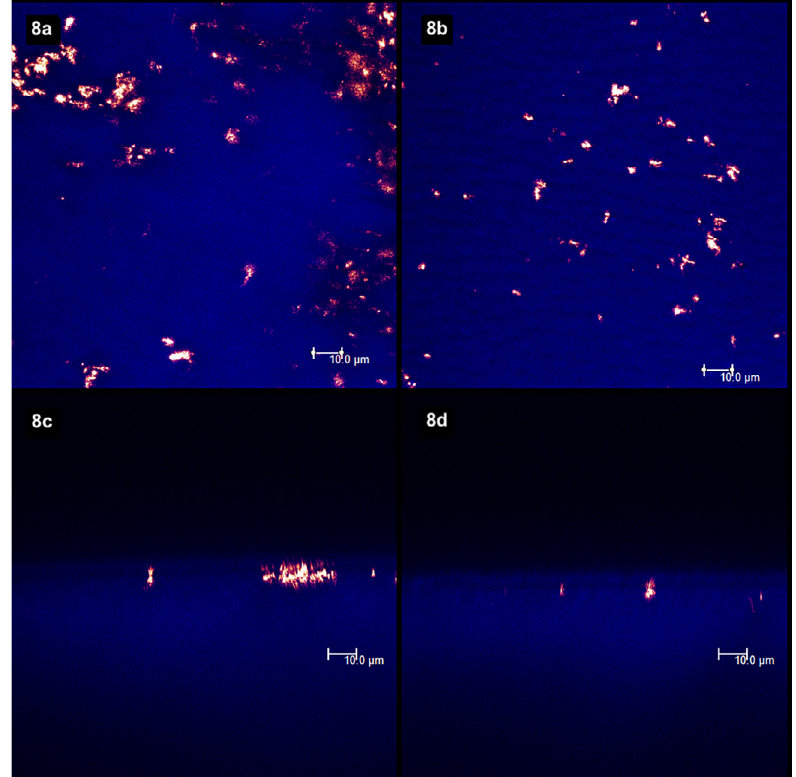
Figure 8- The application of a toothpaste containing 1,450 ppm NaF resulted in the formation of some deposits on the dentin surface (8a) and at the aperture of dentinal tubules (8c). After the erosive challenge, the number